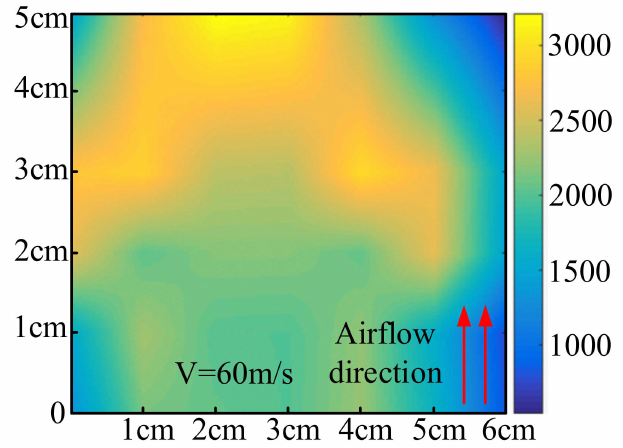
Figure 16. Charge distribution when the gas velocity is 60